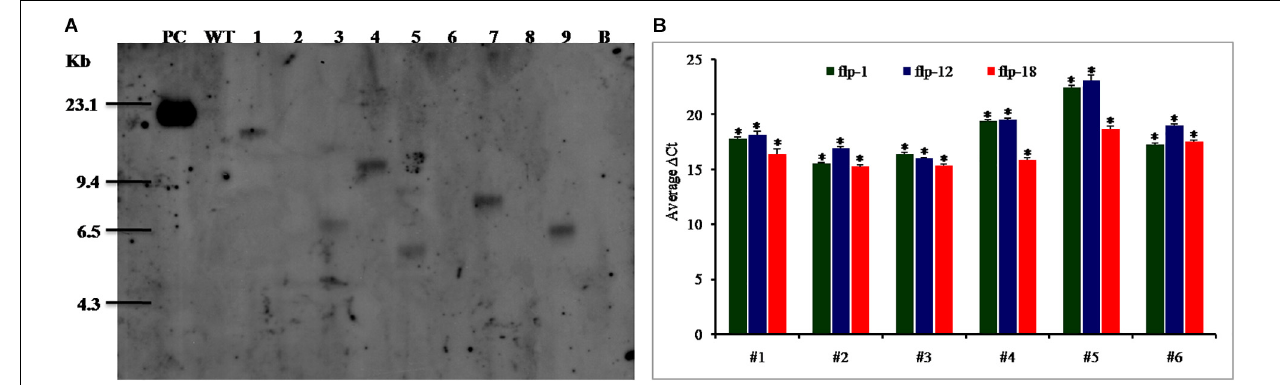
FIGURE 7 | (A) Southern blot analysis of transgenic lines harboring dsRNA construct of FLPs-fusion gene. Lanes 1–9 shows transgenic lines 25-6, 26-2, 27-4, 28-9, 36-12, 37-1, 38-5, 40-5, and 47-2. PC – positive control (linearized recombinant vector pB7GWIWG2(II) (25 pg); WT – negative control (wild-type plant); B – blank, (B) Expression analysis of target genes in Southern positive T 1 plants. Mi-flp1, Mi-flp12 , and Mi-flp18 expressing lines ( #1 to #6 represent lines– 25-6, 27-4, 28-9, 36-12, 38-5, and 47-2). (cid:49) Ct values were calculated using difference in the Ct mean of target gene and reference gene (tobacco 18S rRNA ). Each bar represents the mean ± SE of n = 3, and asterisks shows significant difference at P < 0.05. Higher (cid:49) Ct values specify the lower expression of transgene in the corresponding